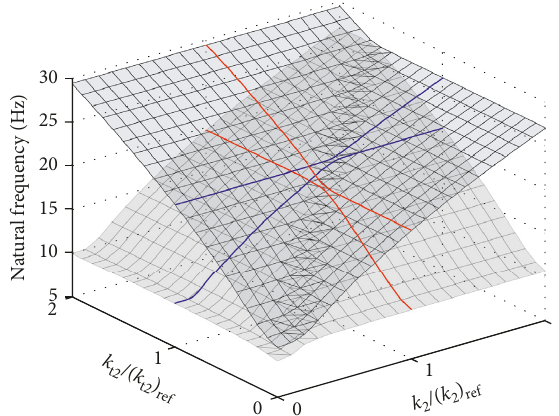
Figure 7: Mode veering between the fourth and fifth modes for variations in k 2 and k t2 , (lower plane: fourth natural frequencies; upper plane: fifth natural frequencies; red line: natural frequency loci when k t2 varies with baseline value of k 2 ; blue line: natural frequency loci with respect to k 2 with baseline value of k t2